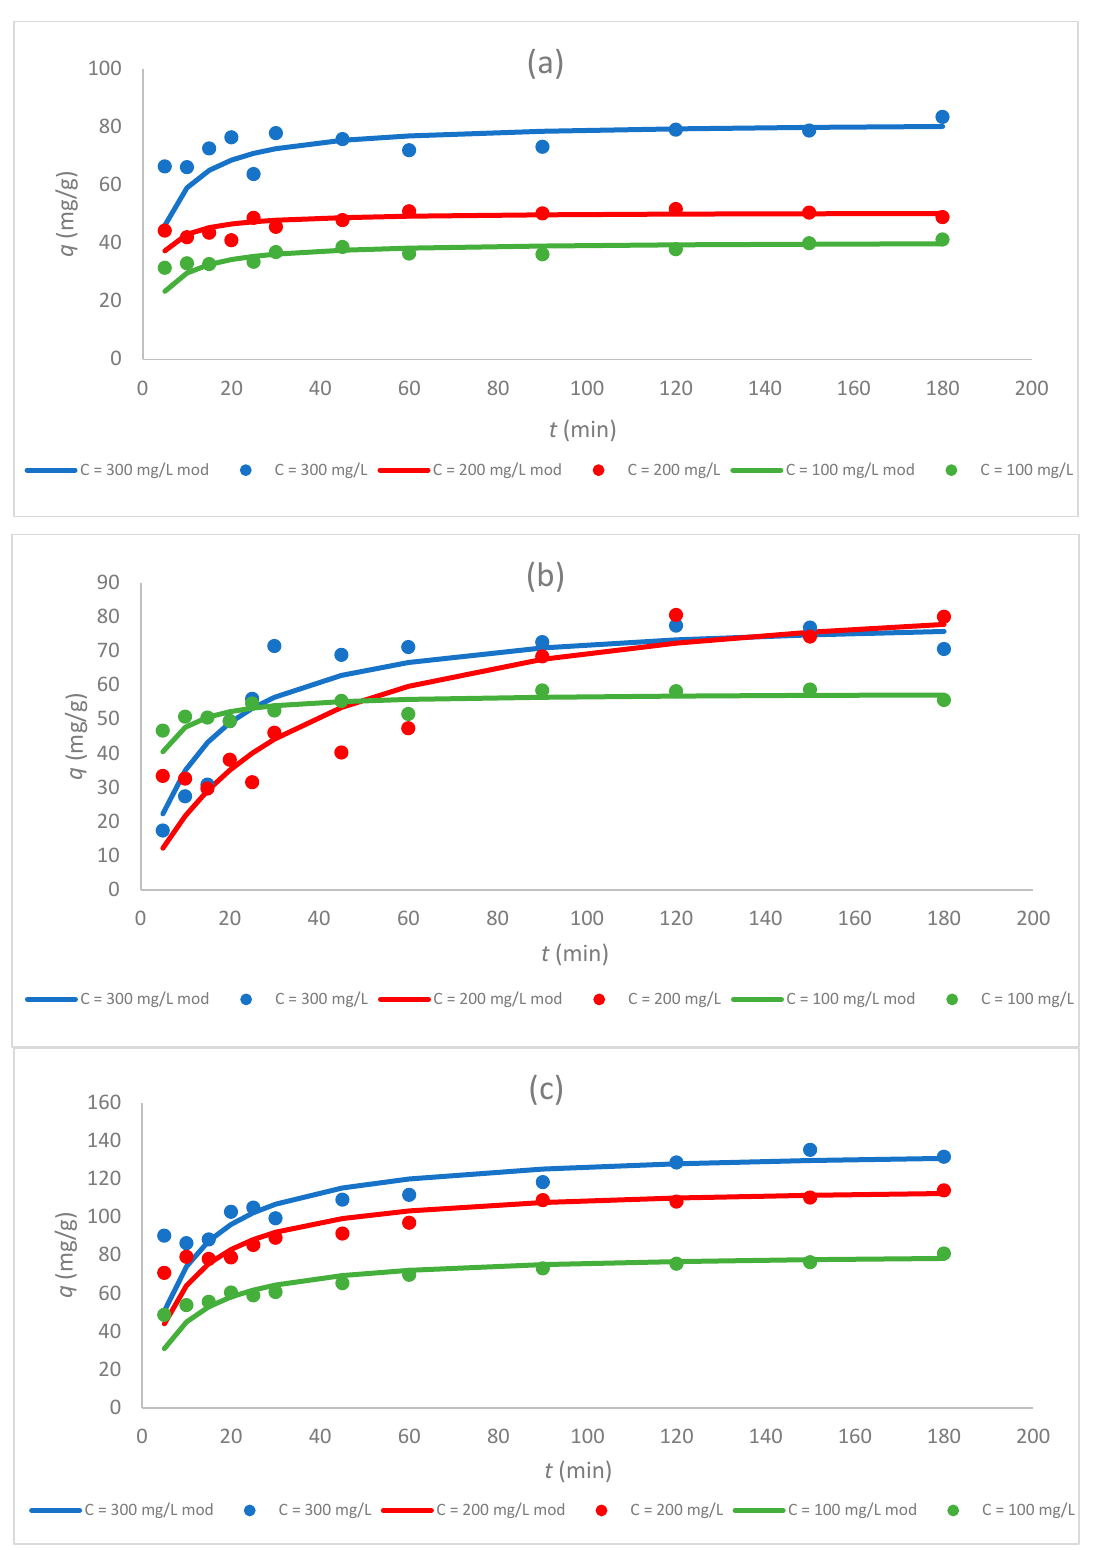
Figure 6. Dependence of the sorption capacity of the tested sorbents ( a ) Sargassum sp., ( b ) Sargassum sp. post-extraction residue, and ( c ) ZnO NPs on time for different initial concentrations of Cr(III) ions (100, 200, and 300 mg/L) at pH 5 and C S 1.0 g/L.